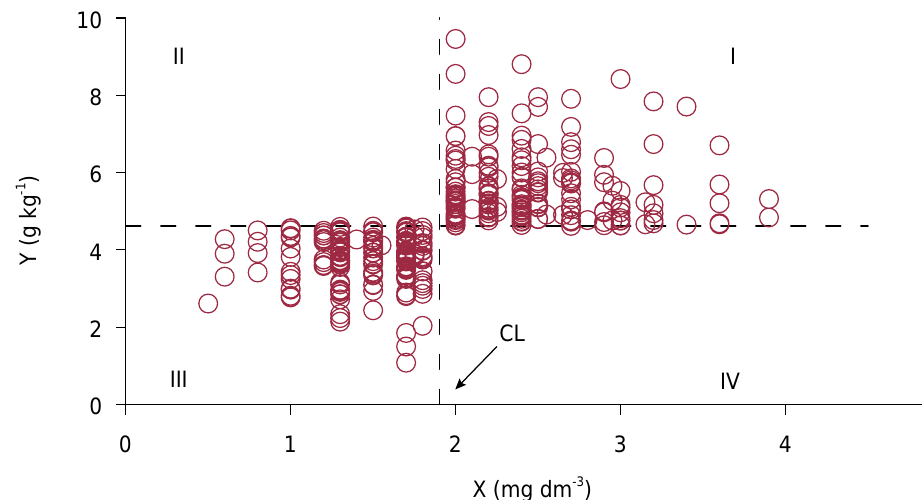
Figure 3. Example of application of the Quadrant Diagram of the Plant-Soil Relationship (QDpsR) method, obtained from the relationship between two variables (nutrient concentrations in the leaf and in the soil).